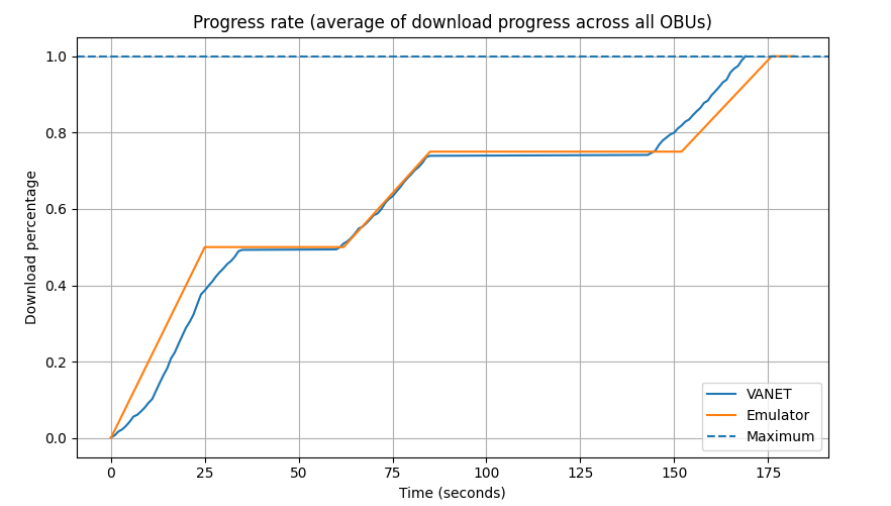
Figure 9. Scenario 1: Comparison of download times of a 50 MB file dissemination in a five node vehicular ad-hoc network (VANET) using InterPlanetary File System (IPFS) vs. EmuCD using